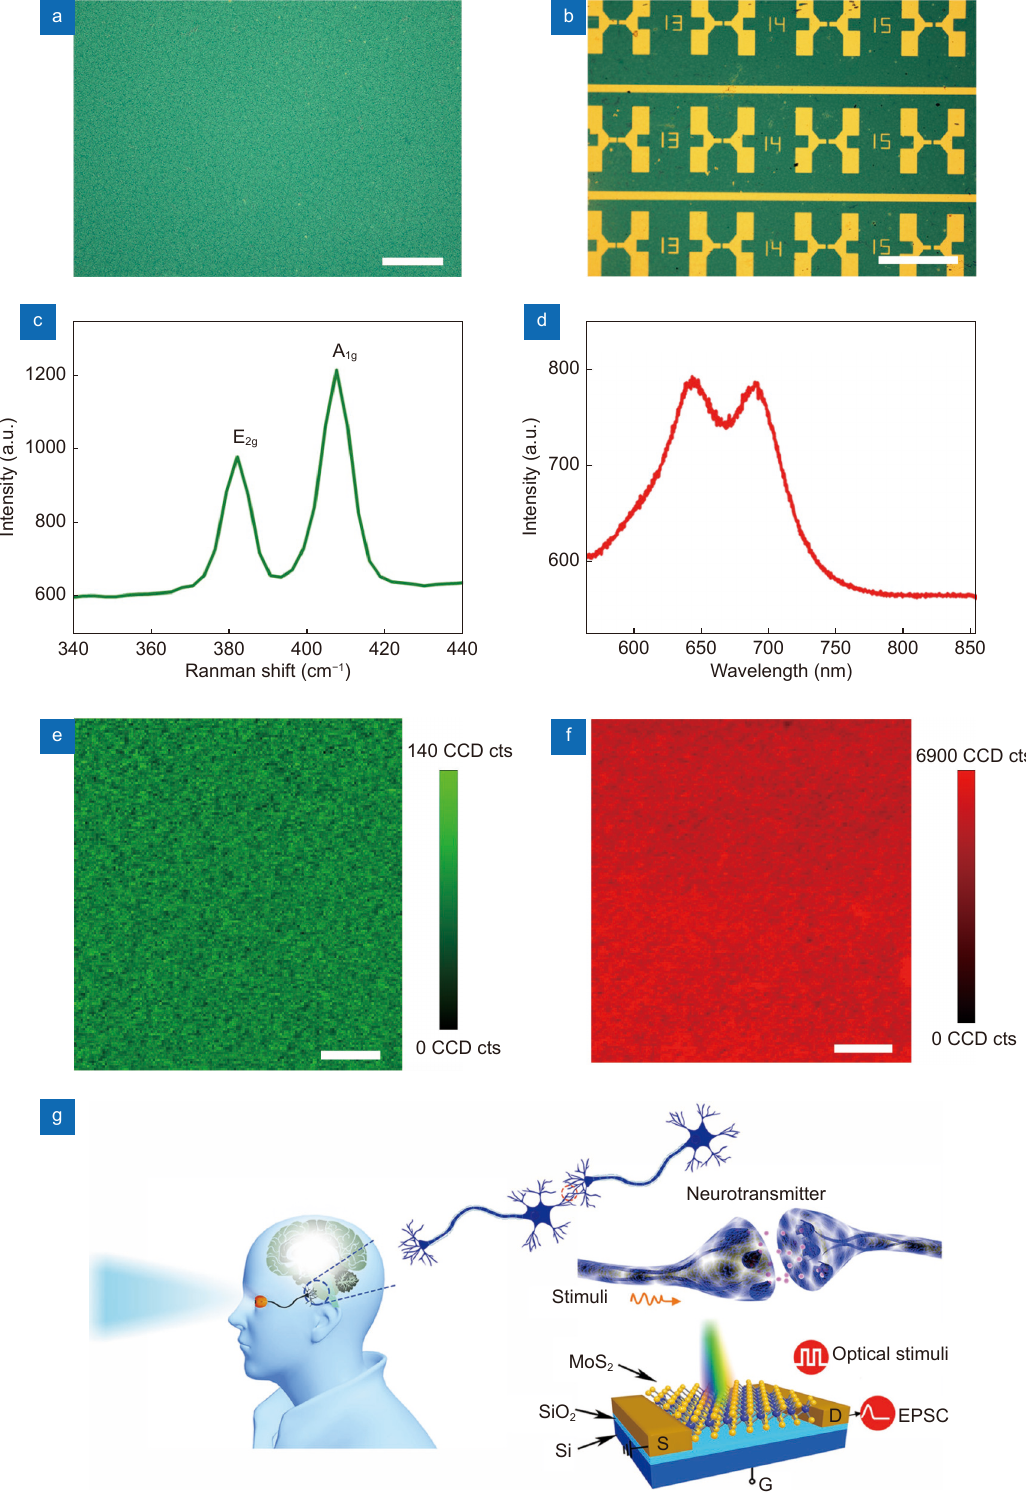
Fig. 1 | Optical characterizations of MoS 2 synaptic transistors and schematic diagram of human eyes. ( a ) The optical image of large-area and uniform polycrystalline MoS 2 . Scale bar: 100 μm. ( b ) The optical photograph of a MoS 2 synaptic transistor array on Si/SiO 2 substrate. Scale bar: 500 μm. The corrsponding Raman spectrum ( c ) and PL spectrum ( d ) of MoS 2 . The corresponding Raman mapping around 381.4 cm –1 ( e ) and PL mapping ( f ) selected randomly from (a). Scale bar: 8 μm. ( g ) Schematic diagram of visual perception and information transmission in hu- man brain and corresponding artifical MoS 2 synaptic